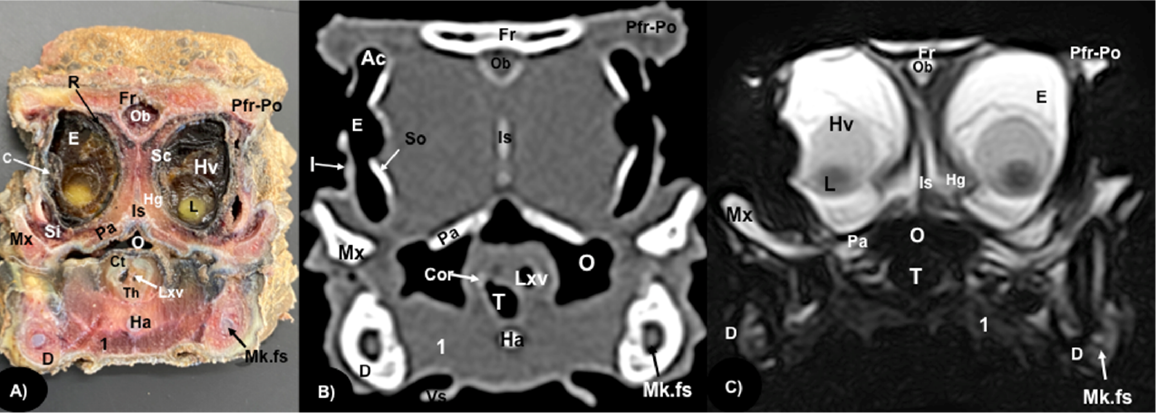
Figure 3. Transversal gross-section ( A ), CT bone window ( B ), and MRI in T2W ( C ), images of the head of rhinoceros iguana in the orbital region corresponding to line II in Figure 1. Fr: Frontal